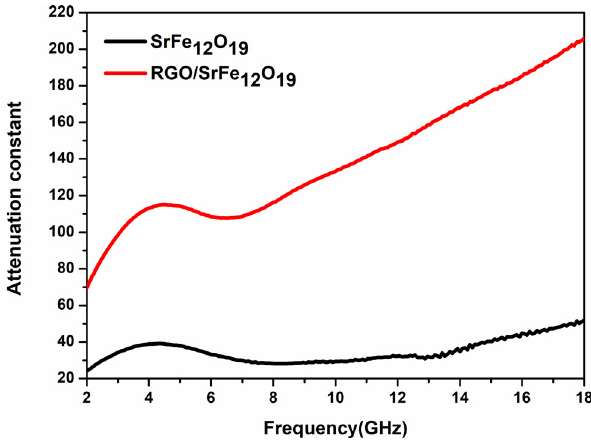
Figure 8: Attenuation constant α of the as-prepared RGO/SrFe 12 O 19 nanocomposites